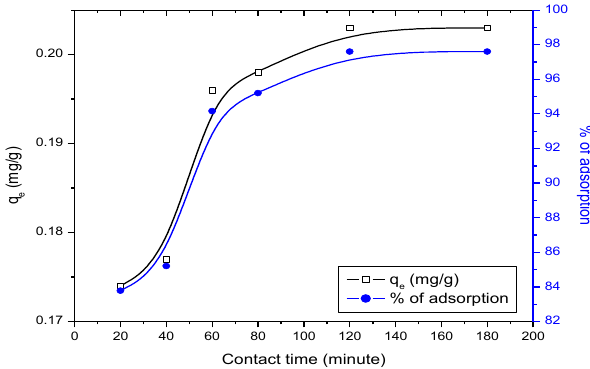
Figure 8. Effect of contact time on the adsorption of fluoride by eggshell powder (experimental conditions: Initial fluoride concentration: 5.0 mg/L, pH: 6.0, adsorbent dose: 2.4 g/100ml and particle size 150µm, agitation speed: 350 rpm, Temperature: 303